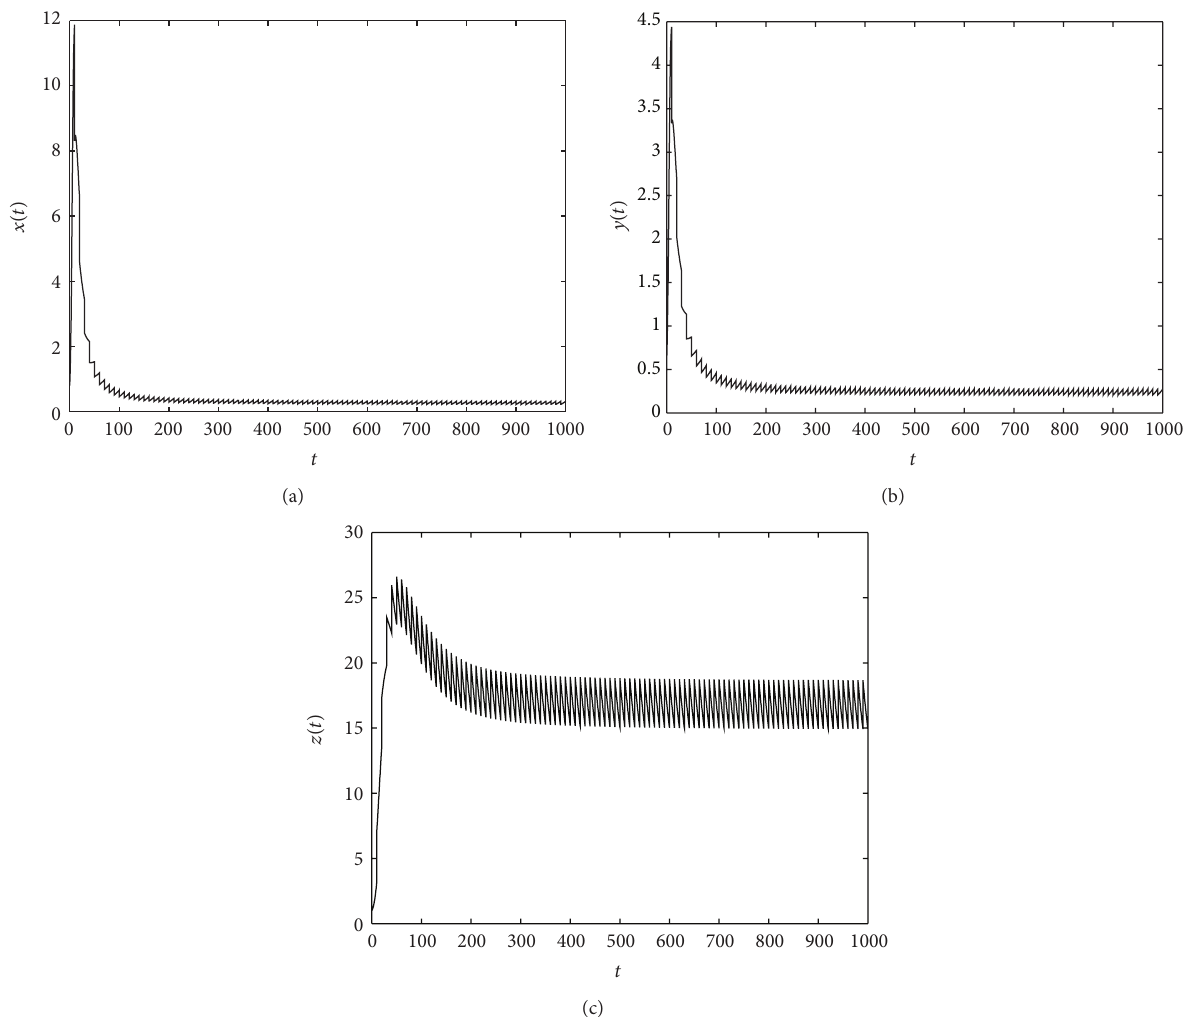
Figure 2: Time series of a solution of model (6) with 𝑞 = 66 : (a) time series of the prey population 𝑥(𝑡) ; (b) time series of the prey population 𝑦(𝑡) ; (c) time series of the predator population 𝑧(𝑡)